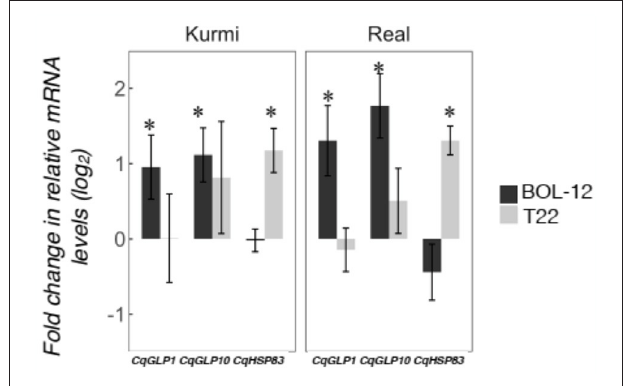
FIGURE 5 | Gene expression changes in quinoa shoots after treatment of roots with Trichoderma . Quinoa shoot samples were assessed by qRT-PCR 36h after treatment with Trichoderma to the roots. Gene expression was normalized to the CqAct2 reference gene and is shown as mean ± SE. Asterisks denote significant changes in the gene expression as compared to the control treatment ( p < 0.05). Two CqGLP genes that were induced in Kurmi roots at 12 hpi as well as the CqHSP83 gene, which was induced in roots in all quinoa- Trichoderma interactions at 12 hpi are shown.